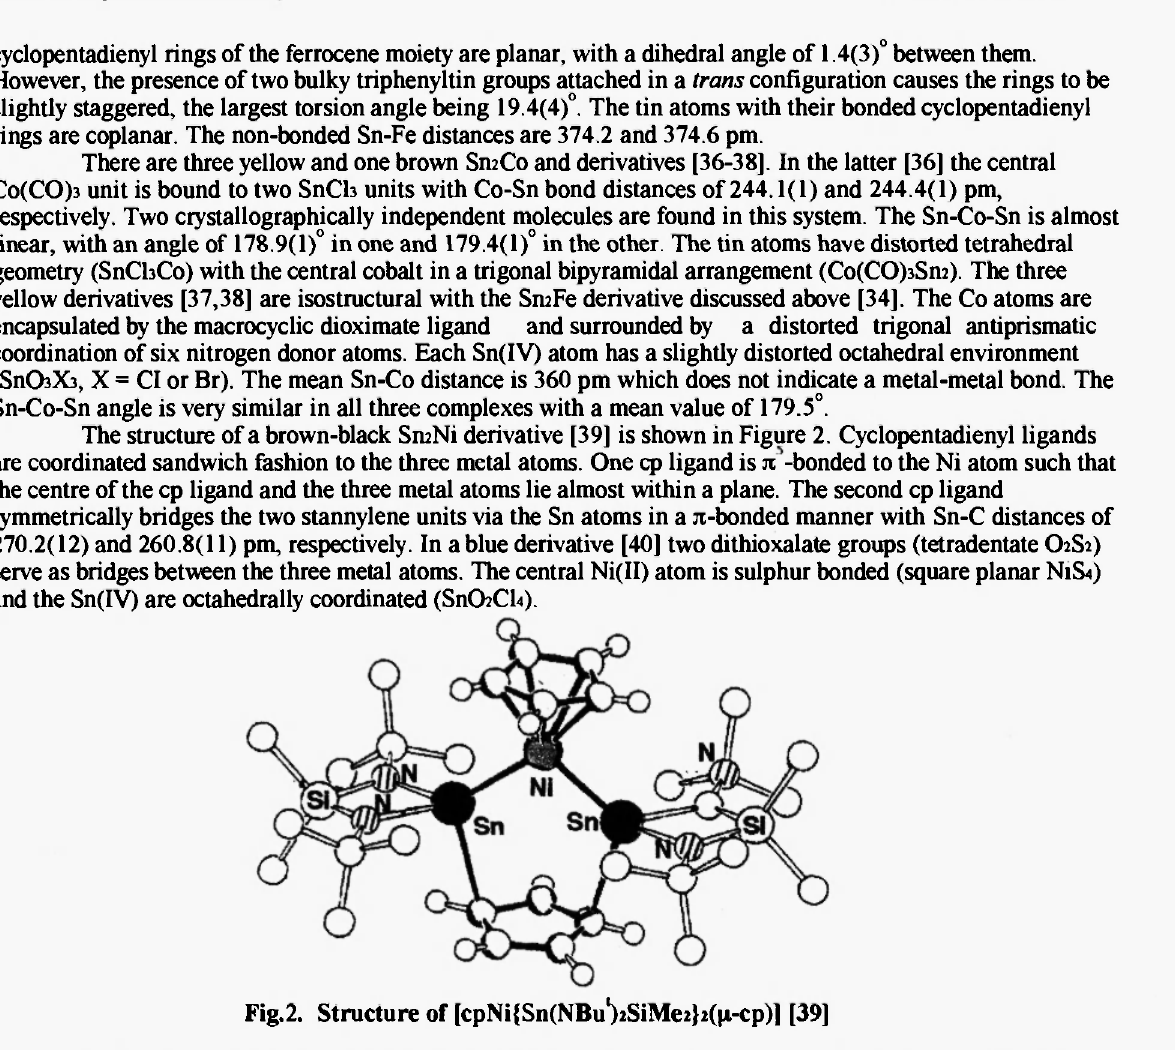
Fig.2. Structure of [cpNi{Sn(NBu ')2SiMe2}2 ^-cp)l